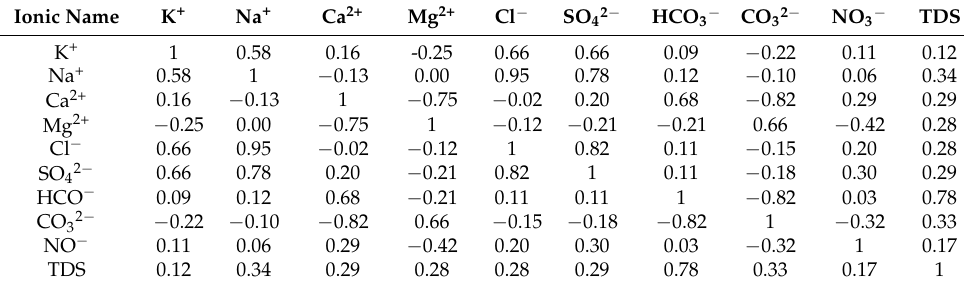
Table 4. Correlation coefficient matrix of ionic